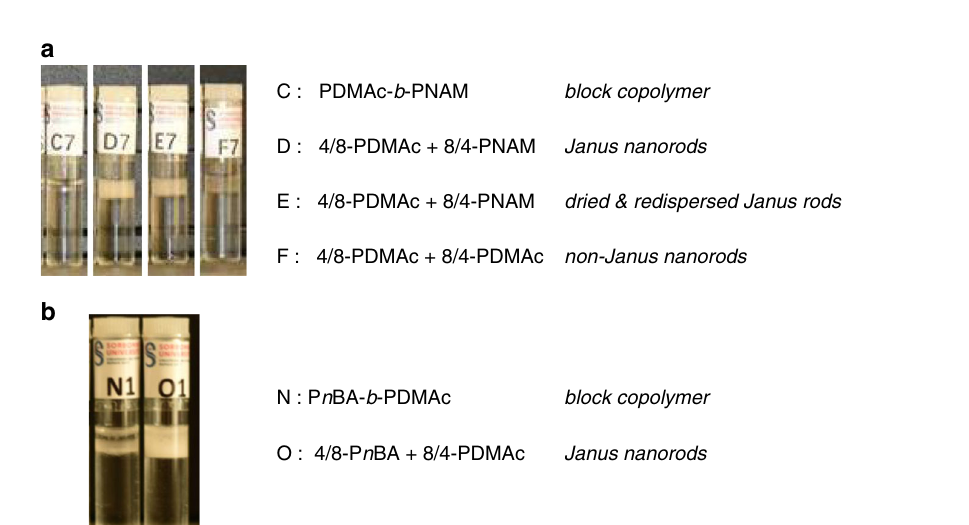
Fig. 2 Local segregation. a Structure of 4/8-PDMAc(D 6 ), 8/4-PDMAc and 4/8-PCEA. b SANS data of equimolar co-assemblies in D 2 O (freeze-dried particles, 10 g L − 1 ). The curves are fi ts with the form factor of cylinders of elliptical cross-section that have the same homogeneous contrast. Dimensions of the cross-sections are indicated on the inset (The discrepancy between the model and the experiment at high q is due to the fact that the solvated polymer chains at the surface of the objects are not explicitly taken into account by the form factor of a simple cylinder). c 1 H NOESY NMR contour plot of (4/8- PDMAc + 8/4-PNAM) equimolar mixture in D 2 O (freeze-dried particles, 5 g L − 1 ). The red ellipses highlight the absence of cross-relaxation peaks between the PDMAc and PNAM chains (compare to Supplementary Fig. 27). d Normalized 1 H transverse relaxation signal A ( t )/ A 0 of the PDMAc CH 3 protons (squares) and the PNAM OCH 2 CH 2 N protons (circles) in the (4/8-PDMAc + 8/4-PNAM) equimolar mixture (solid symbols) or in the pristine polymer (hollow symbols) (1 g L − 1 in D 2 O, obtained by dialysis). e TEM of (4/8-PCEA + 8/4-PDMAc) equimolar mixture (negative staining). White arrows highlight the PCEA-side of some Janus nanorods. Yellow arrows highlight contrast inversion along the nanorods axis. f Gray scale analysis of marked rods in ( e ). See Supplementary Figs. 30 and 31 for more data and control experiment.